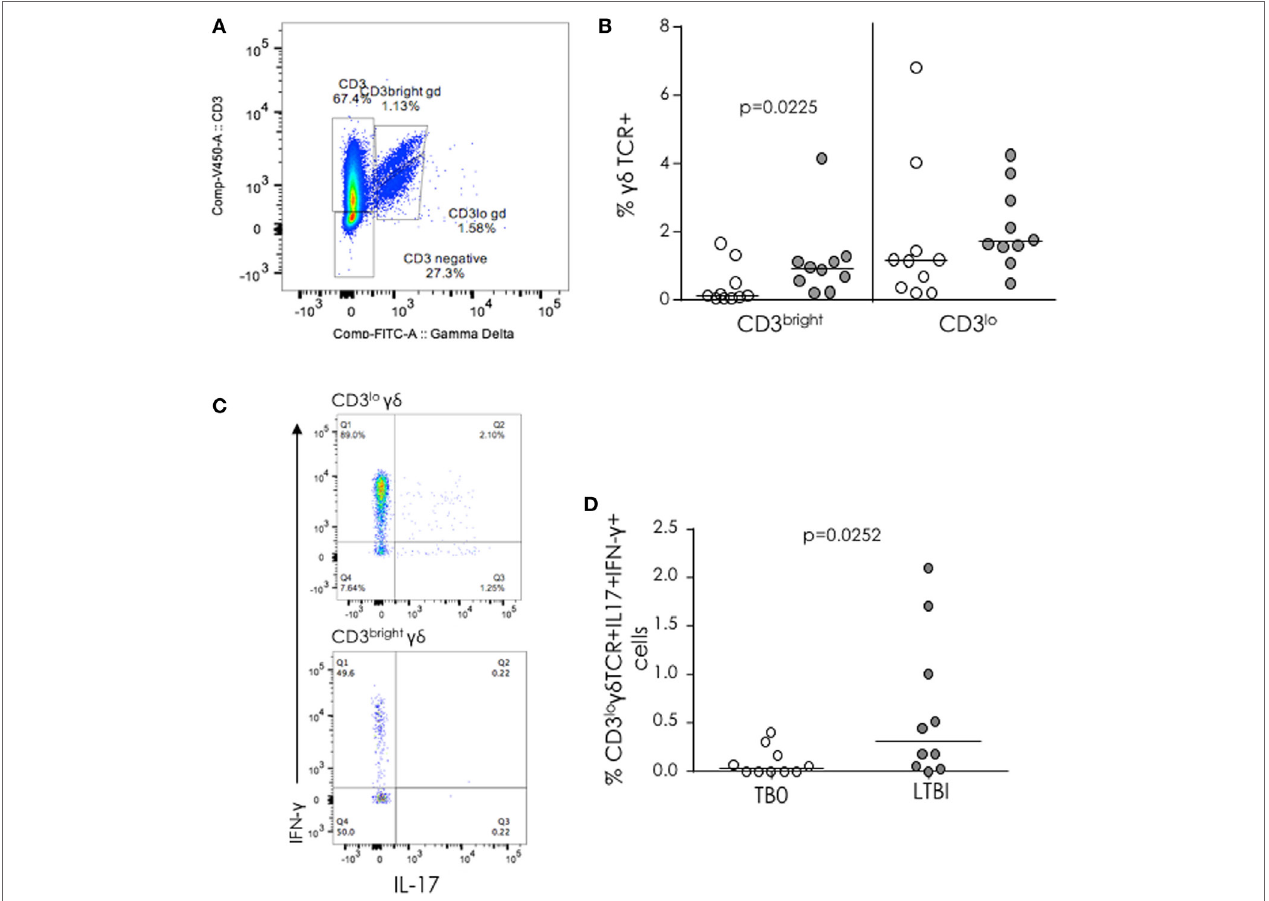
FigUre 3 | γδ T cells in tuberculosis (TB) infection and disease. (a) Representative FACS plot showing V γ 9 δ 2 TCR + cells with low (lo) and bright CD3 expression. (B) Proportion of CD3 bright and CD3 lo γδ T cells from TB patients (white dots) and latently TB infected (LTBI) (gray dots). (c) Representative FACS plots of IFN- γ and IL-17 expression from CD3 lo cells. (D) % IL-17 + IFN- γ + γδ T cells from TB cases (TB0) and LTBI. Data were analyzed with Mann–Whitney U -test. Bar indicates